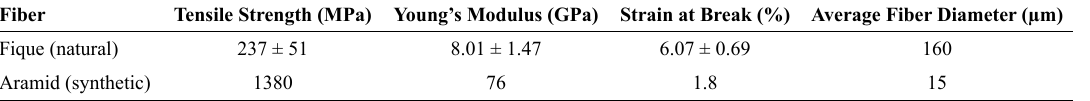
Table 1. Mechanical properties of the fique fibers 19,20 and aramid fiber 21 .